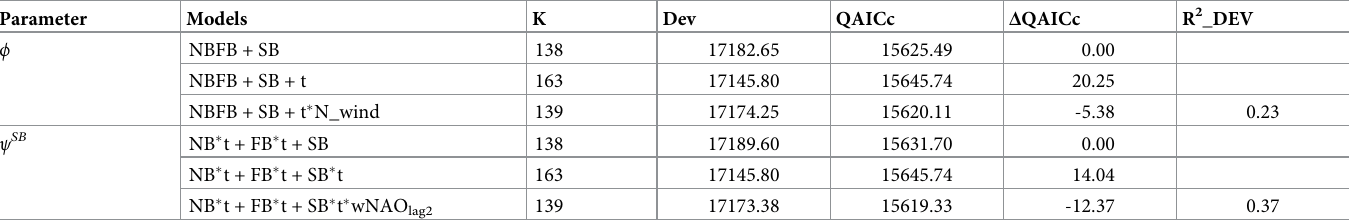
Table 2. Step-up ANODEV selection procedure to identify climate covariates that significantly improve the amount of deviance explained by the multi-state cap- ture-recapture model describing rates of survival ( ϕ ), breeding propensity ( ψ ) and breeding success ( ω ) of Manx shearwaters breeding on Skomer Island 1993–2019.